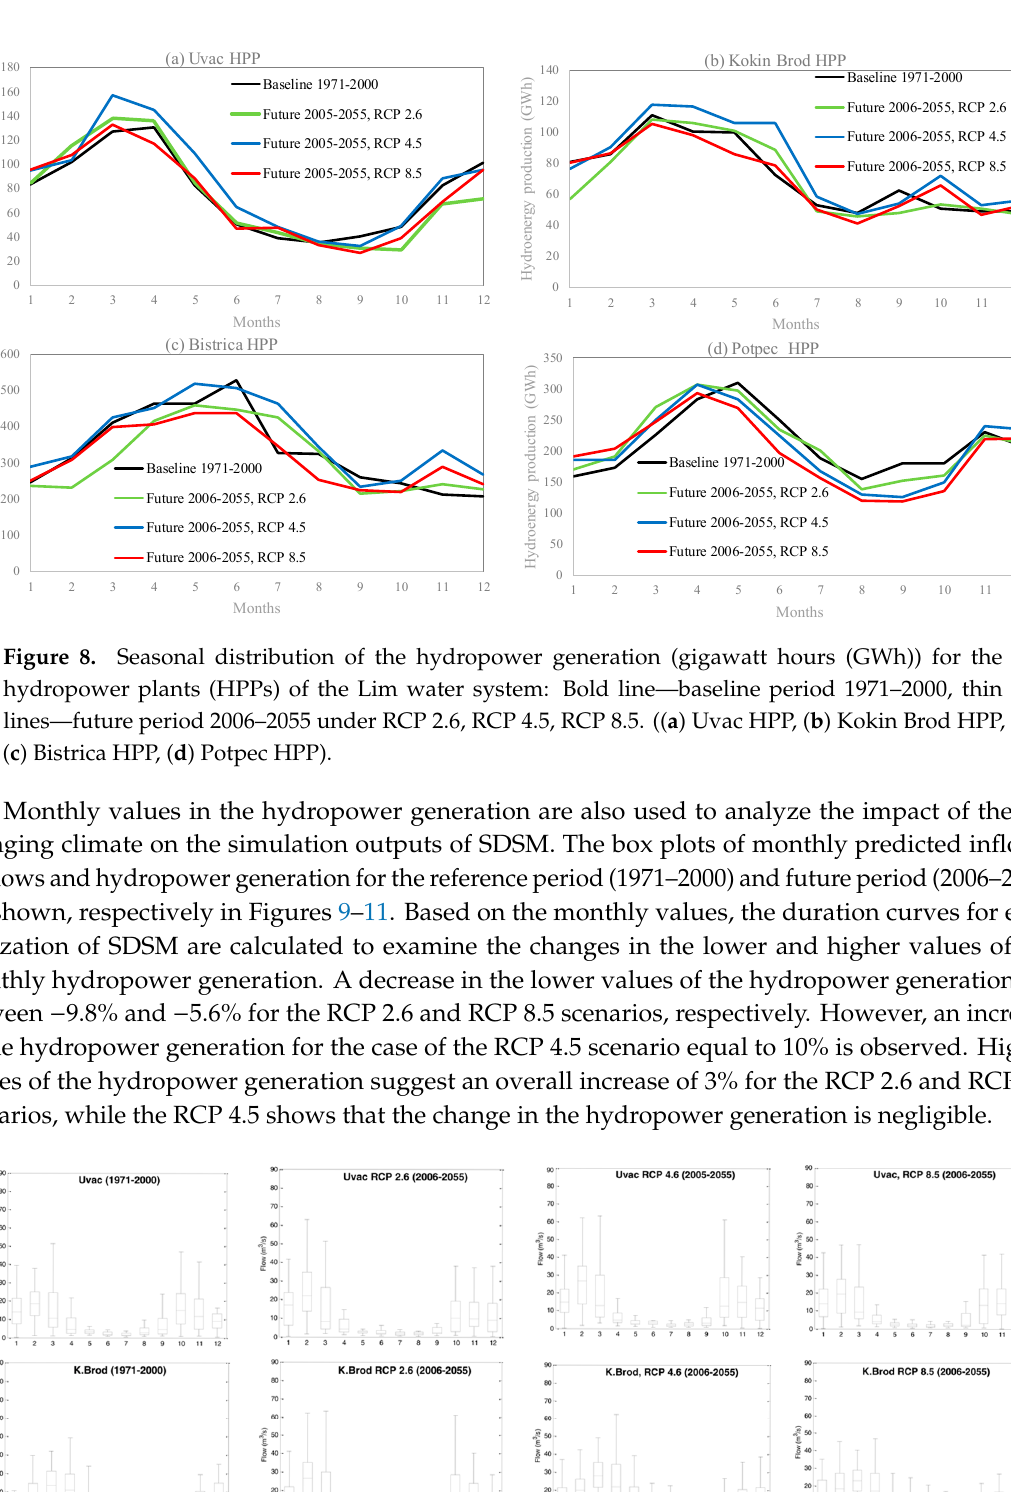
Figure 9. Box plots of the monthly inflows into the Lim water system (Uvac, Kokin Brod, Radojnja and Potpec).